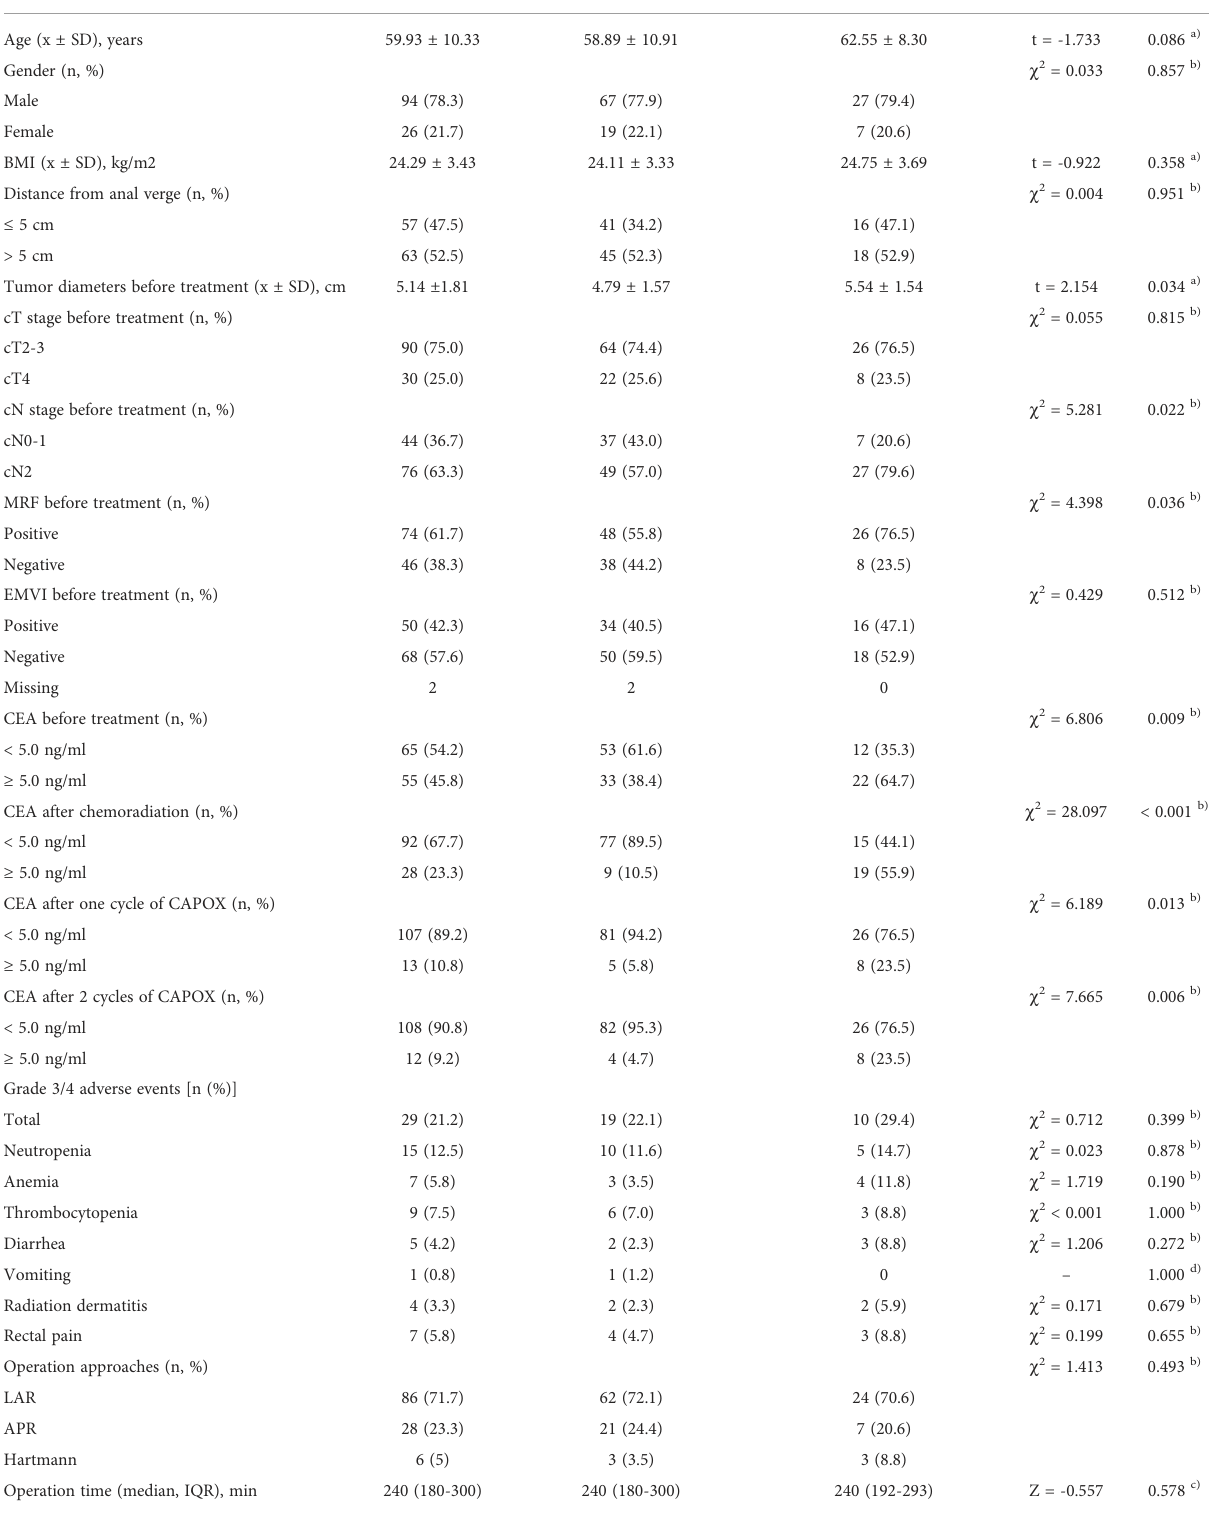
TABLE 1 Clinical and pathological characteristics of patients with locally advanced rectal cancer following total neoadjuvant therapy strati fi ed by tumor regression